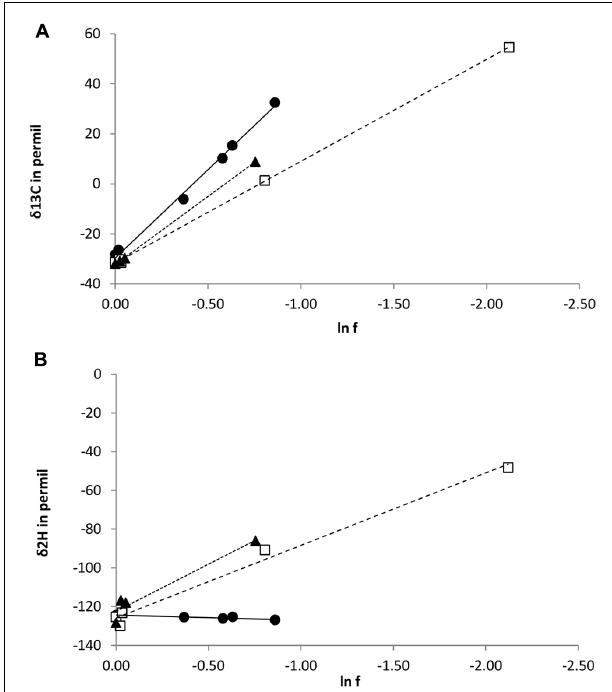
FIGURE 3 | Isotope variations of chloromethane during bacterial cultivation with chloromethane. (A) δ 13 C and (B) δ 2 H in relation to the fraction of remaining chloromethane (f). Lines represent best-fit linear regressions. L. methylohalidivorans MB2 (•), M. extorquens CM4 ( (cid:2) ), and Hyphomicrobium sp. MC1 ( (cid:3) ).